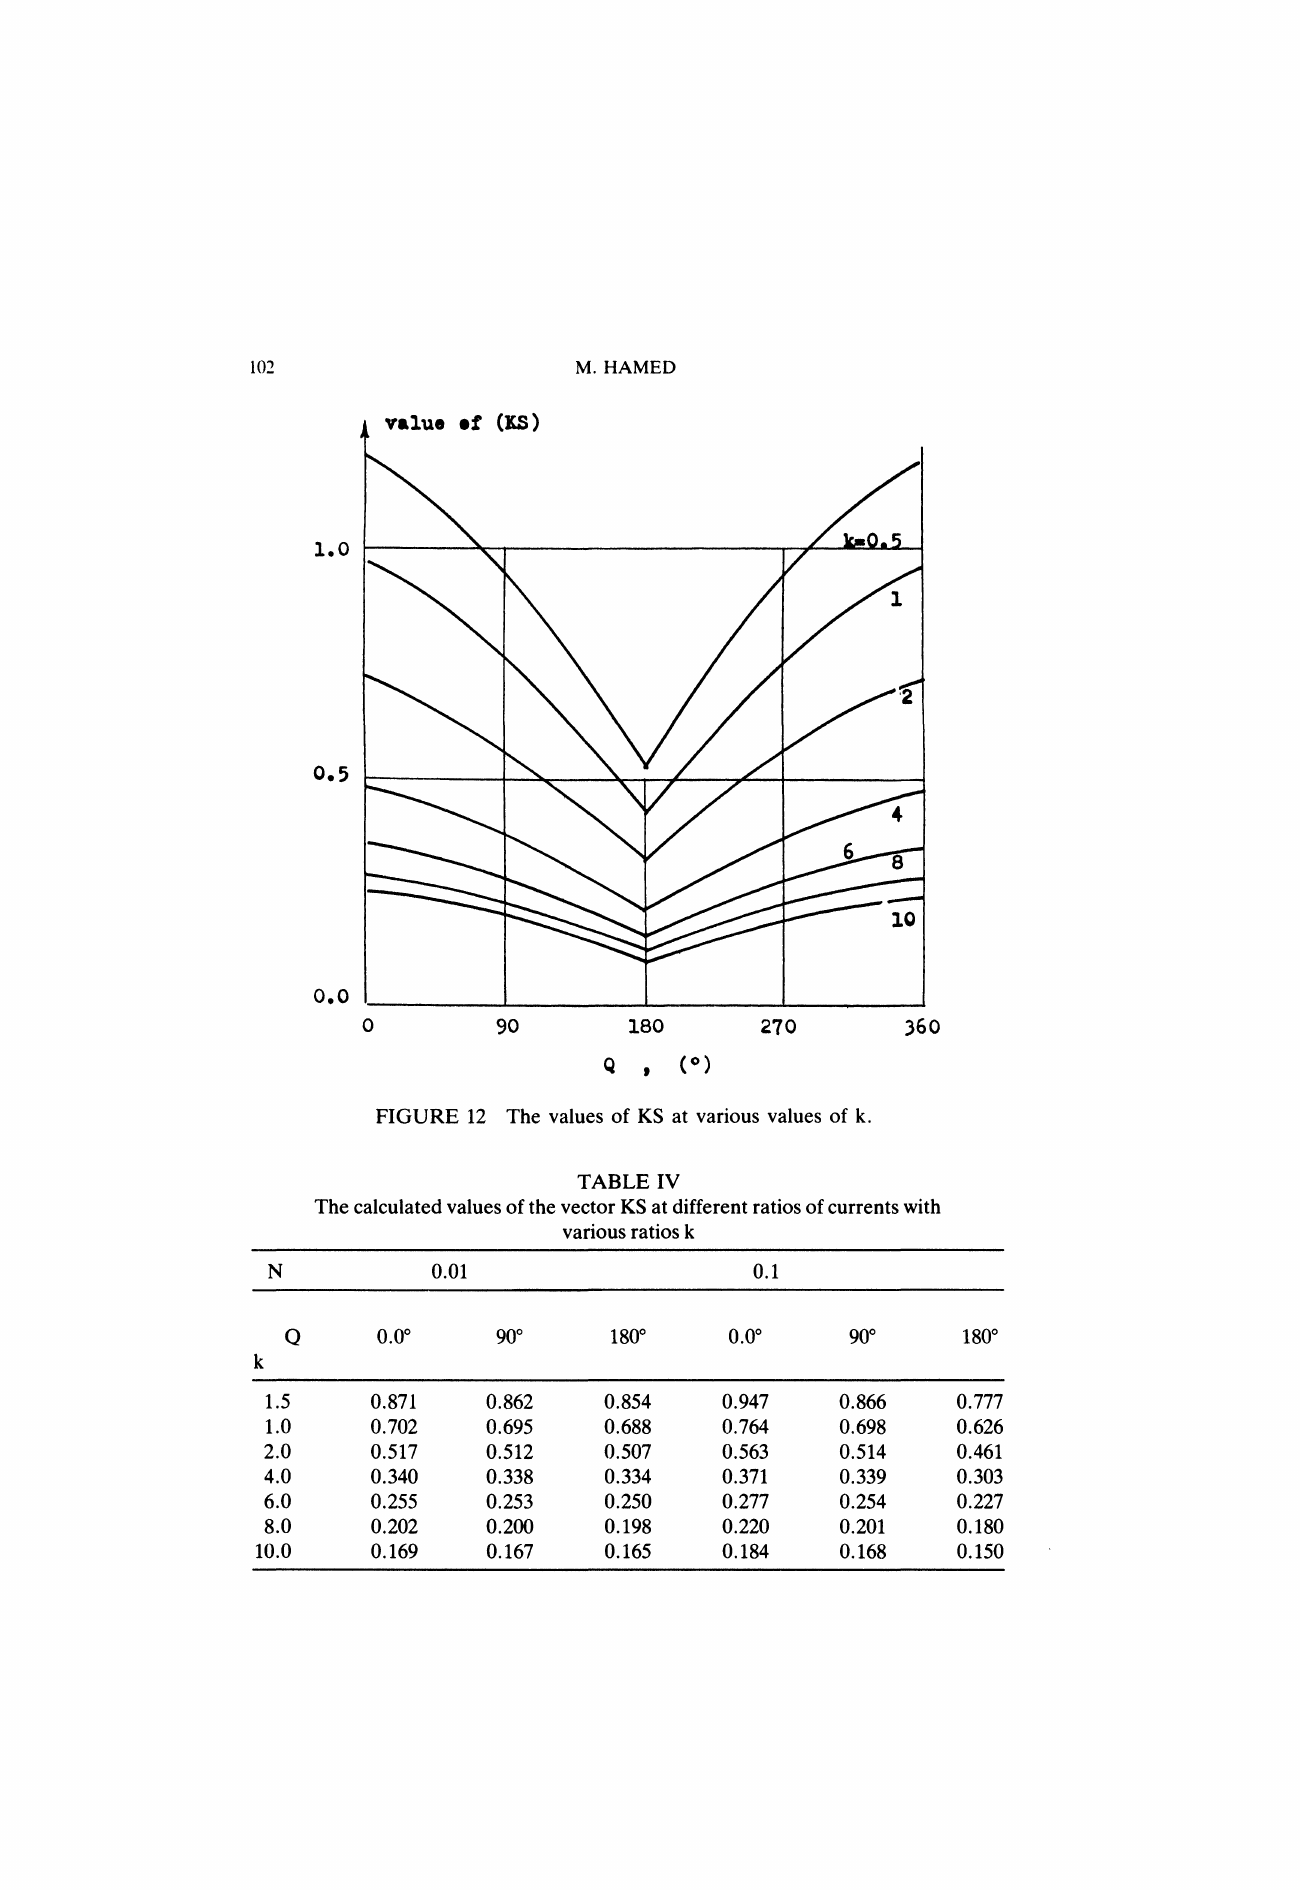
FIGURE 12 The values of KS at various values of k.